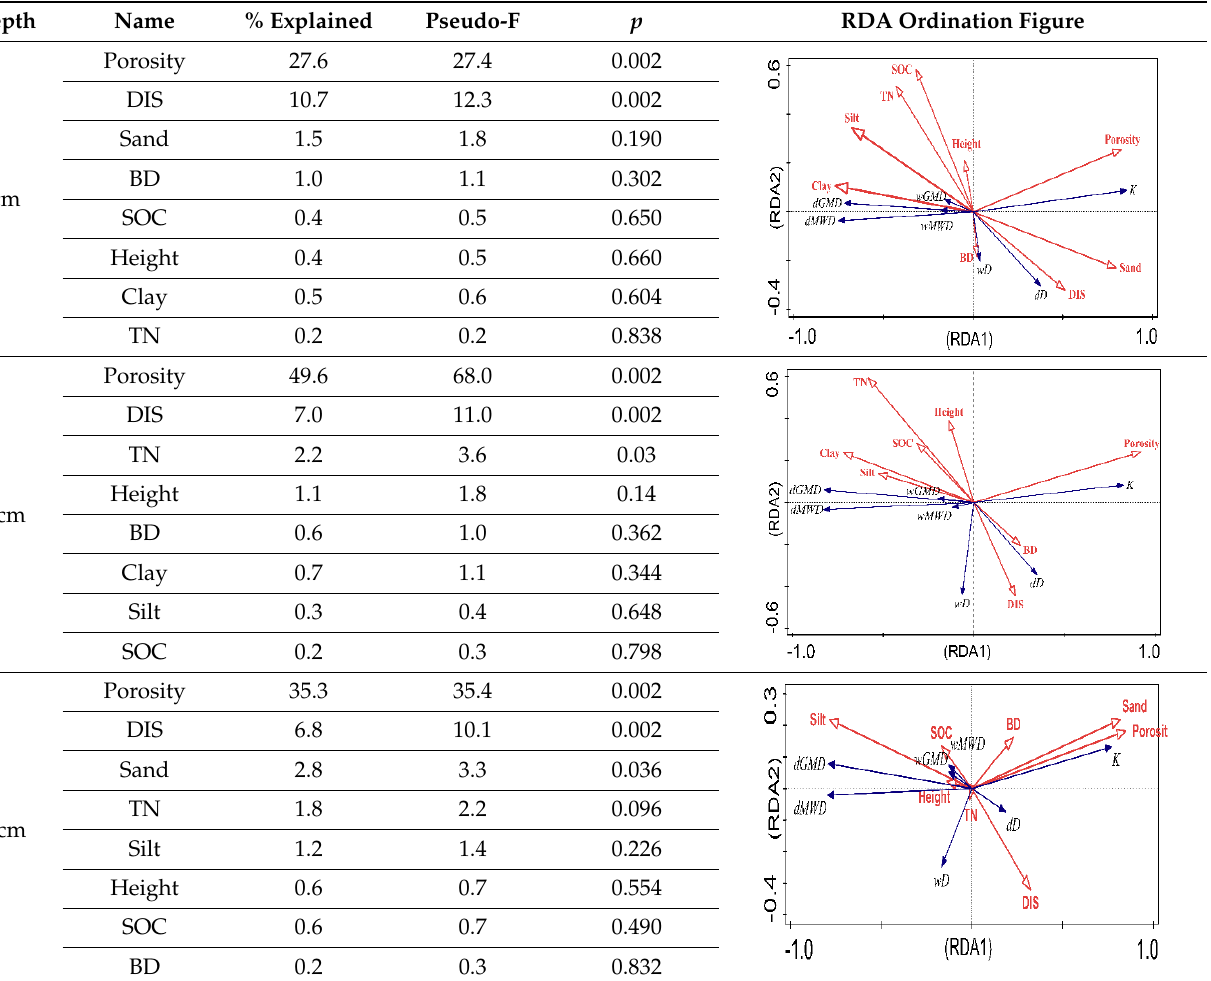
Table 3. Comparison of the explanatory power of shelterbelt characteristics, soil texture and soil properties in the variation of soil aggregate characteristics in farmland at different distances from shelterbelts from RDA ordination-related conditional term effects, excluding co-linear effects.